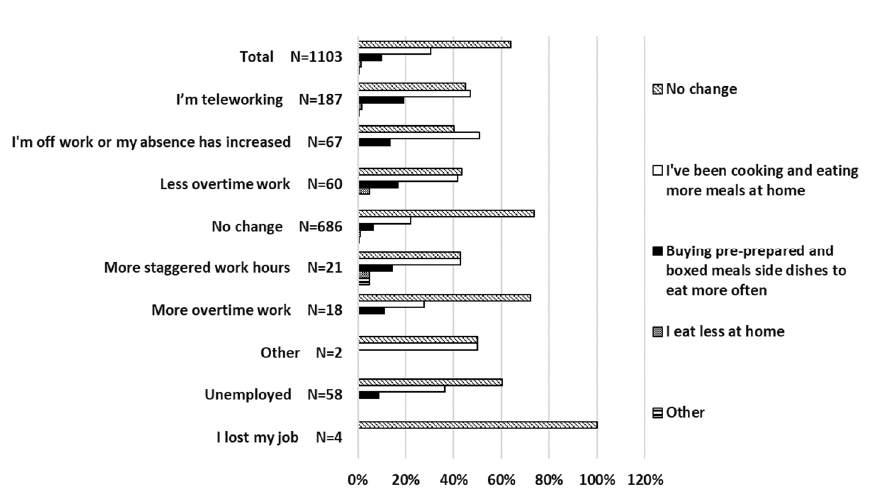
Figure 12. Changes in the way respondents prepare meals (multiple responses).